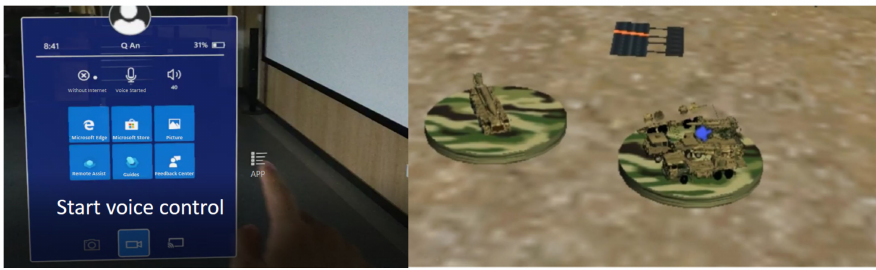
Figure 19. Flowchart of using voice to control missile